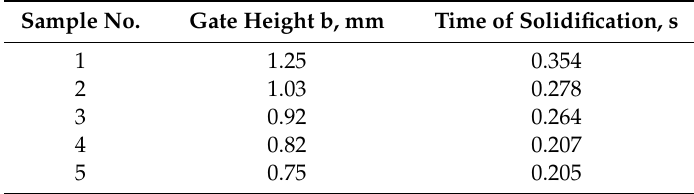
Table 8. Solidification time in the area of the gate.